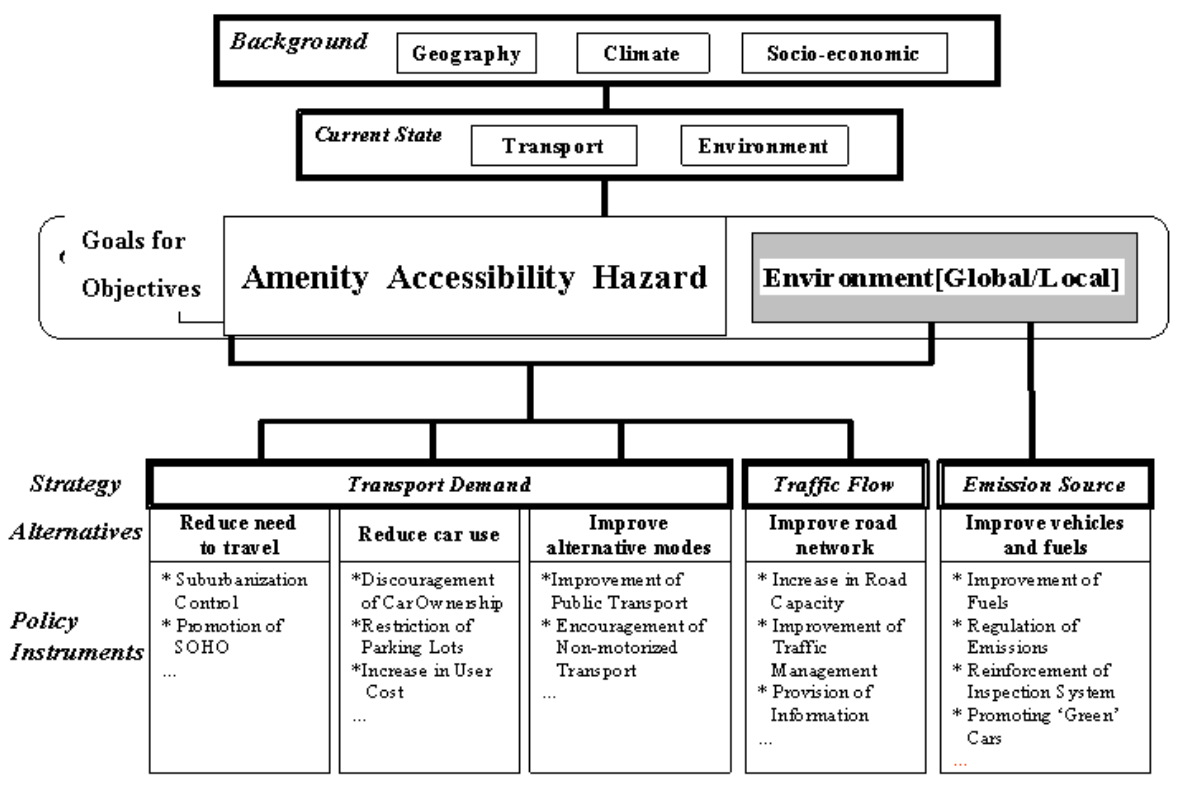
Figure 1. Goals, Strategies and Policy Instruments for Integrated Land Use and Transport Solutions to Environmental Problems. Source: